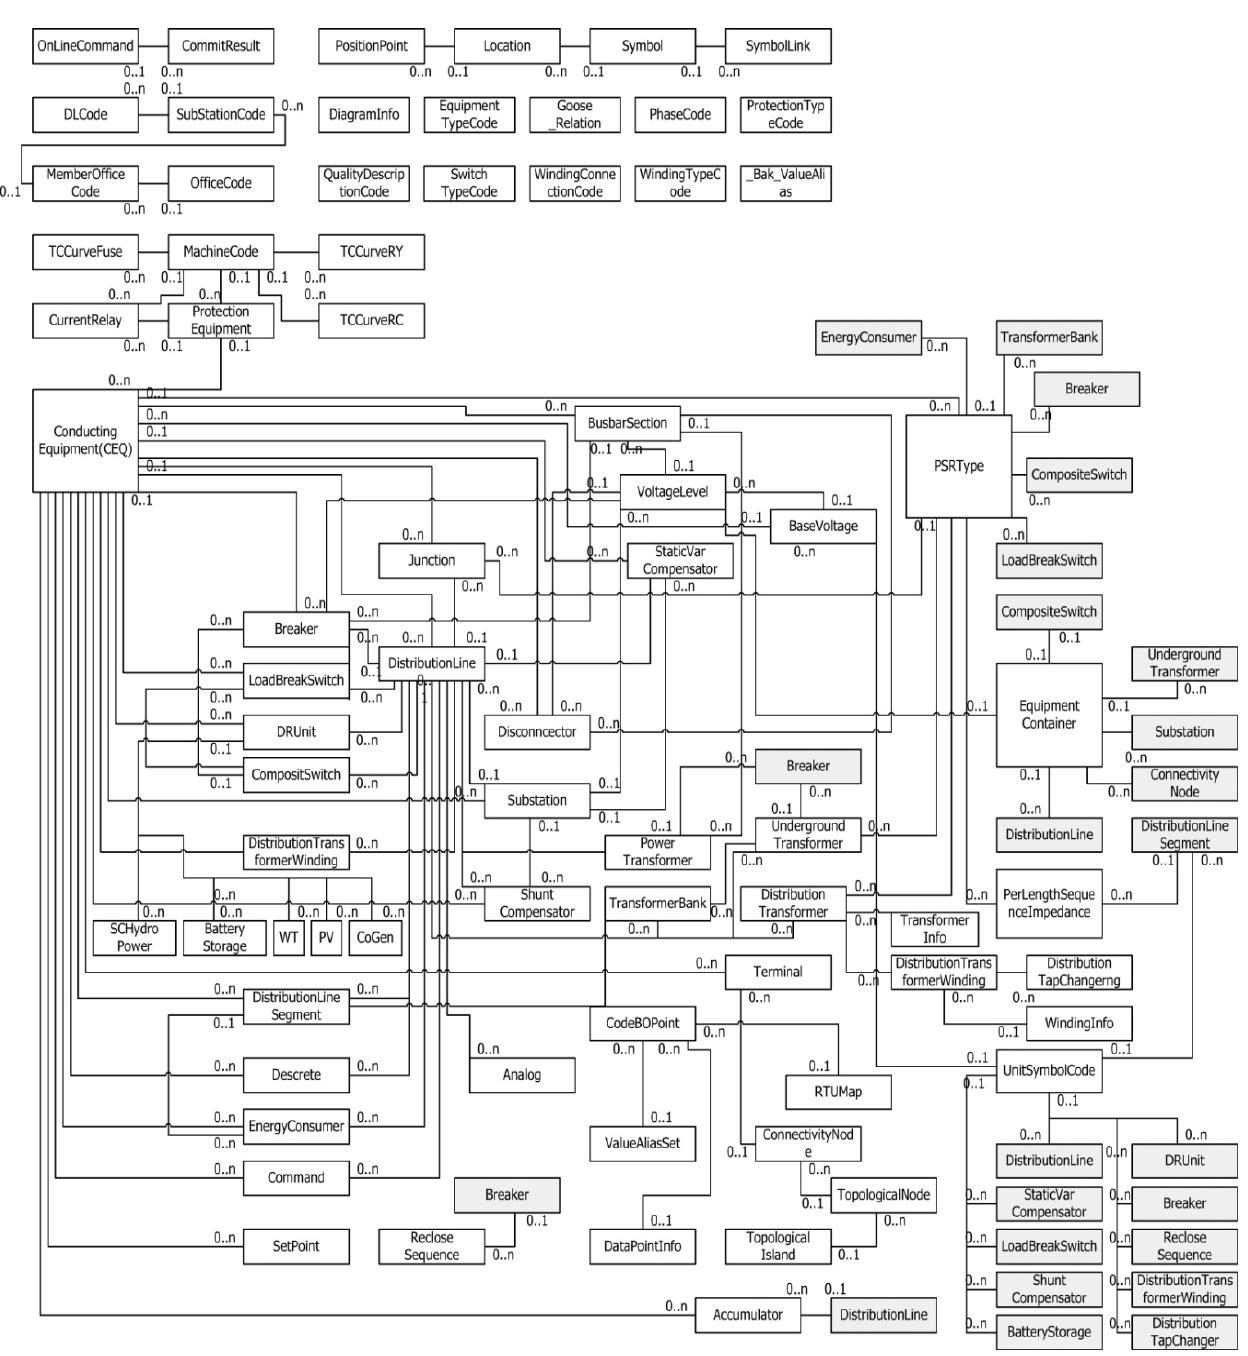
Figure 5. CIM DB structure converted into an RDBMS